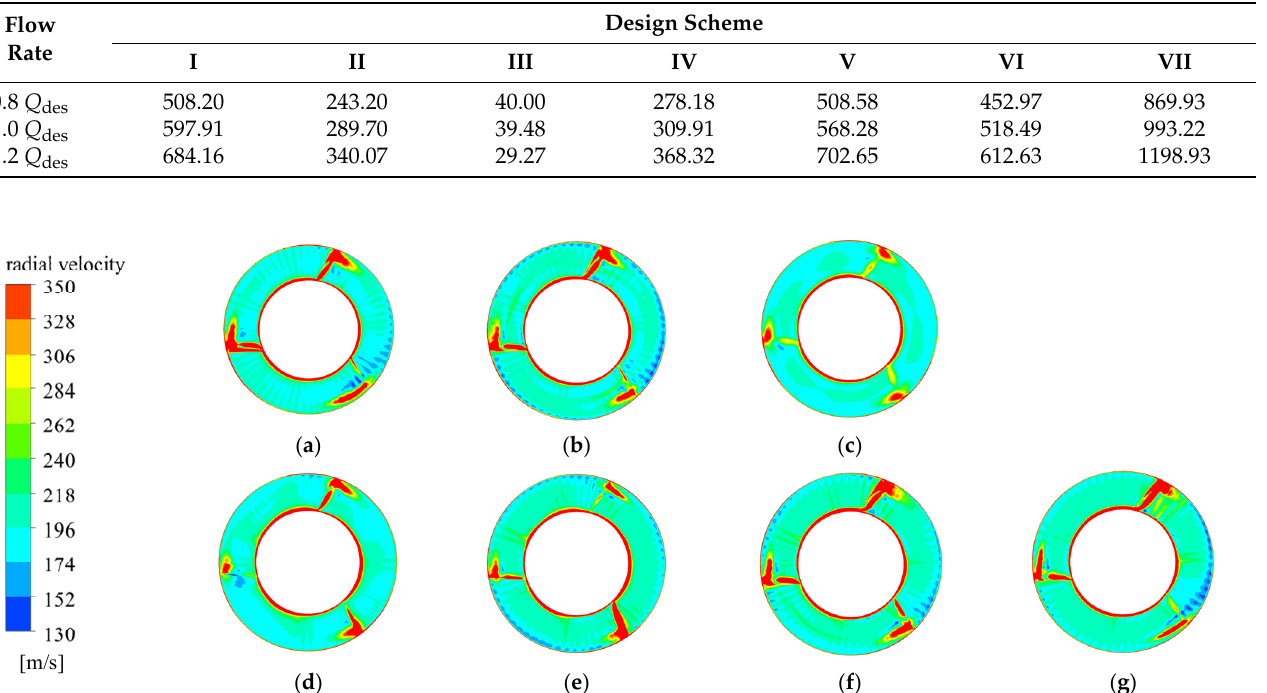
Figure 19. Radial velocity distribution at impeller outlet under 1.0 Q des conditions: ( a ) Design Scheme I; ( b ) Design Scheme II; ( c ) Design Scheme III; ( d ) Design Scheme IV; ( e ) Design Scheme V; ( f ) Design Scheme VI; and ( g ) Design Scheme